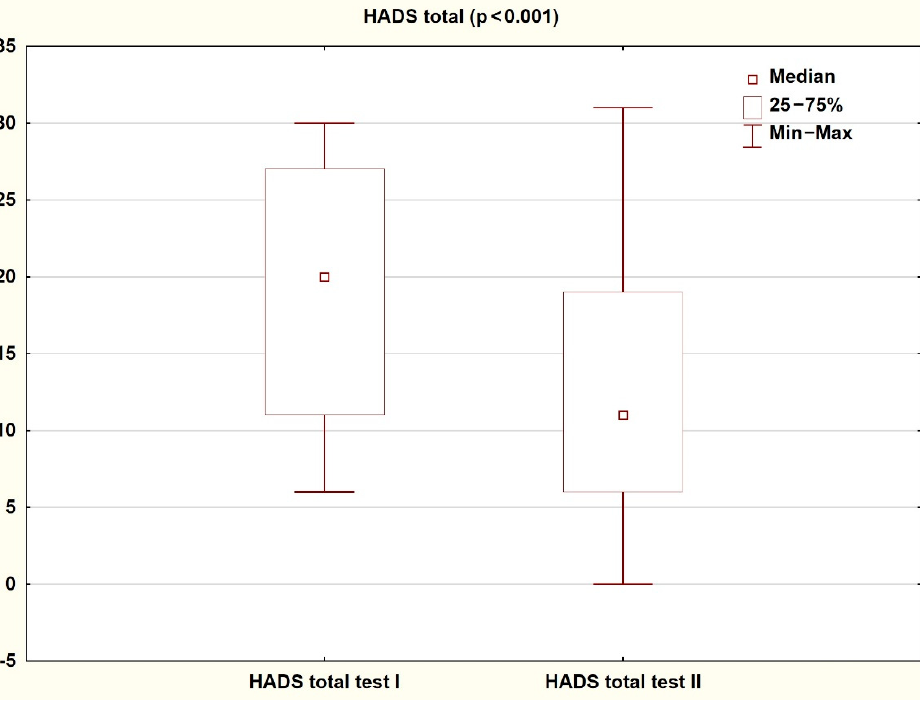
Figure 4. Patient results in the HADSscale during the first and second study (Wilcoxon test).